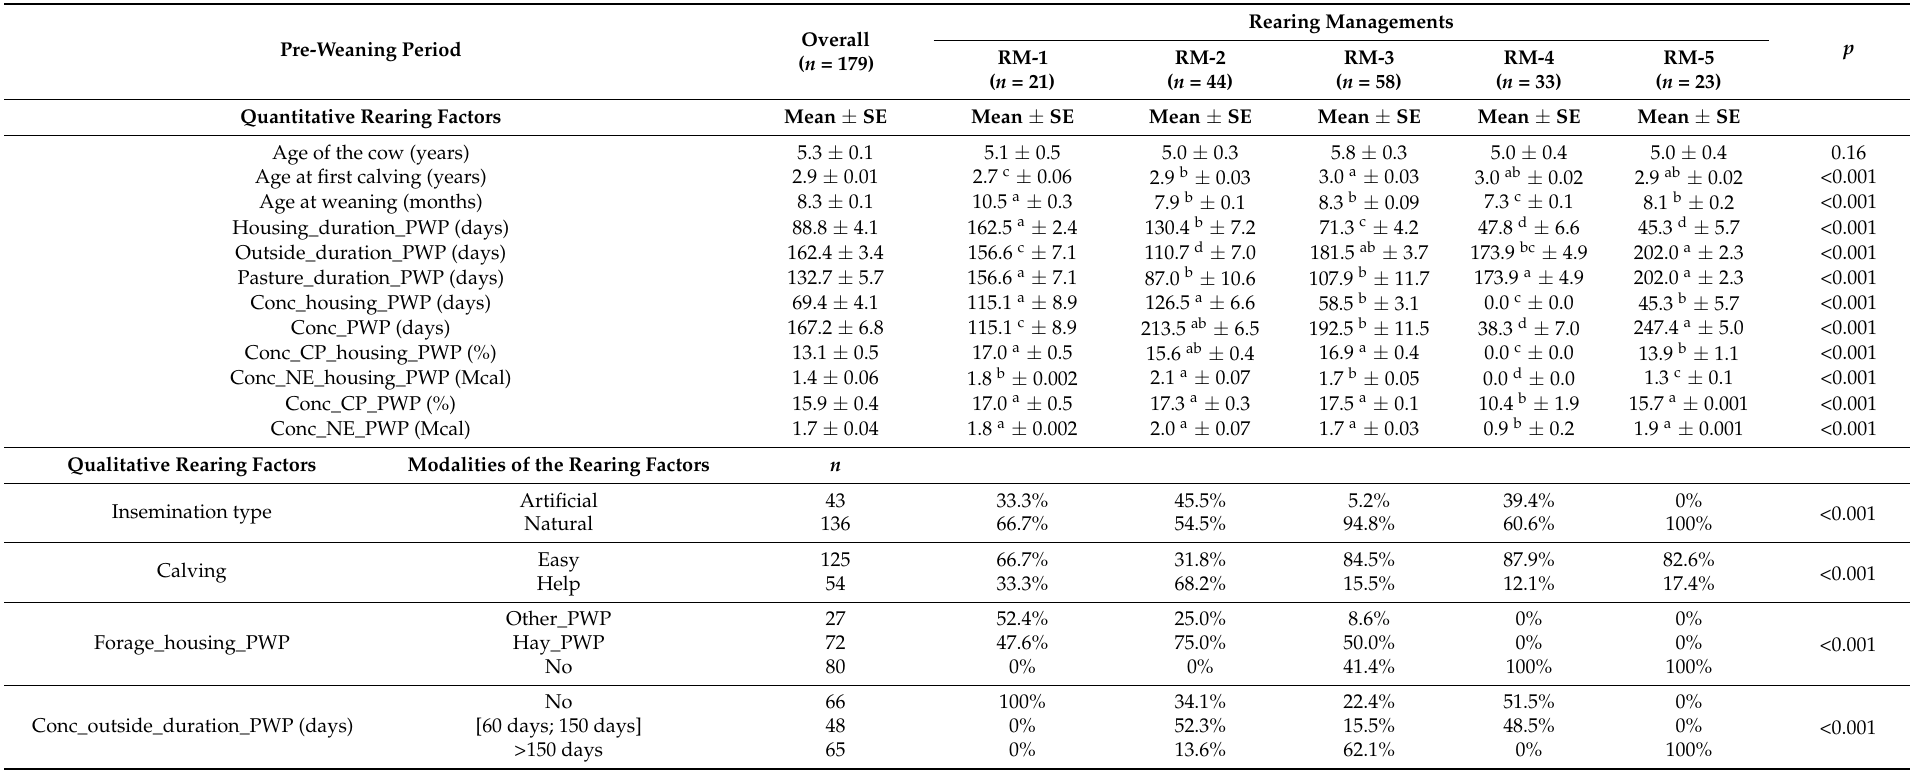
Table 3. Rearing factors characterizing the pre-weaning period (PWP) of the rearing managements (RMs) applied throughout the whole life of the young bulls.